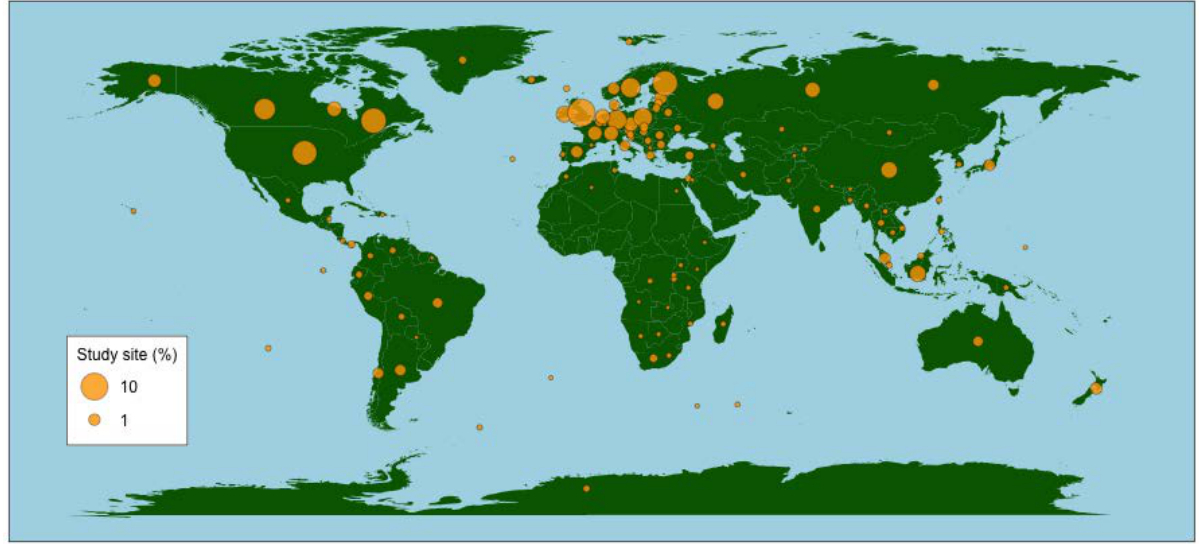
Figure 5. Proportion of study sites, relative to the global total, for 1991–2017. Proportion shown by circle area. Examples 10 % and 1 % in